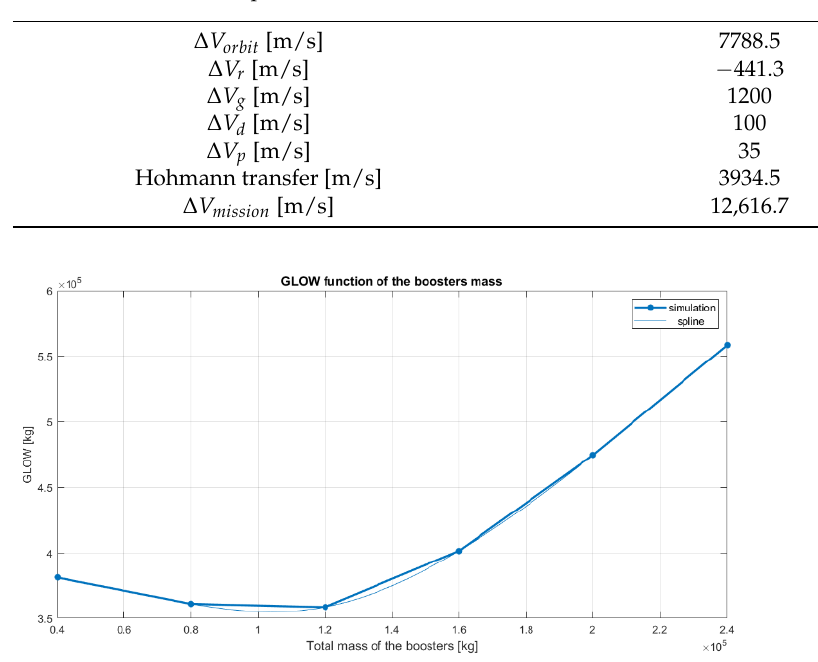
Table 4. Delta-V for the planned mission.